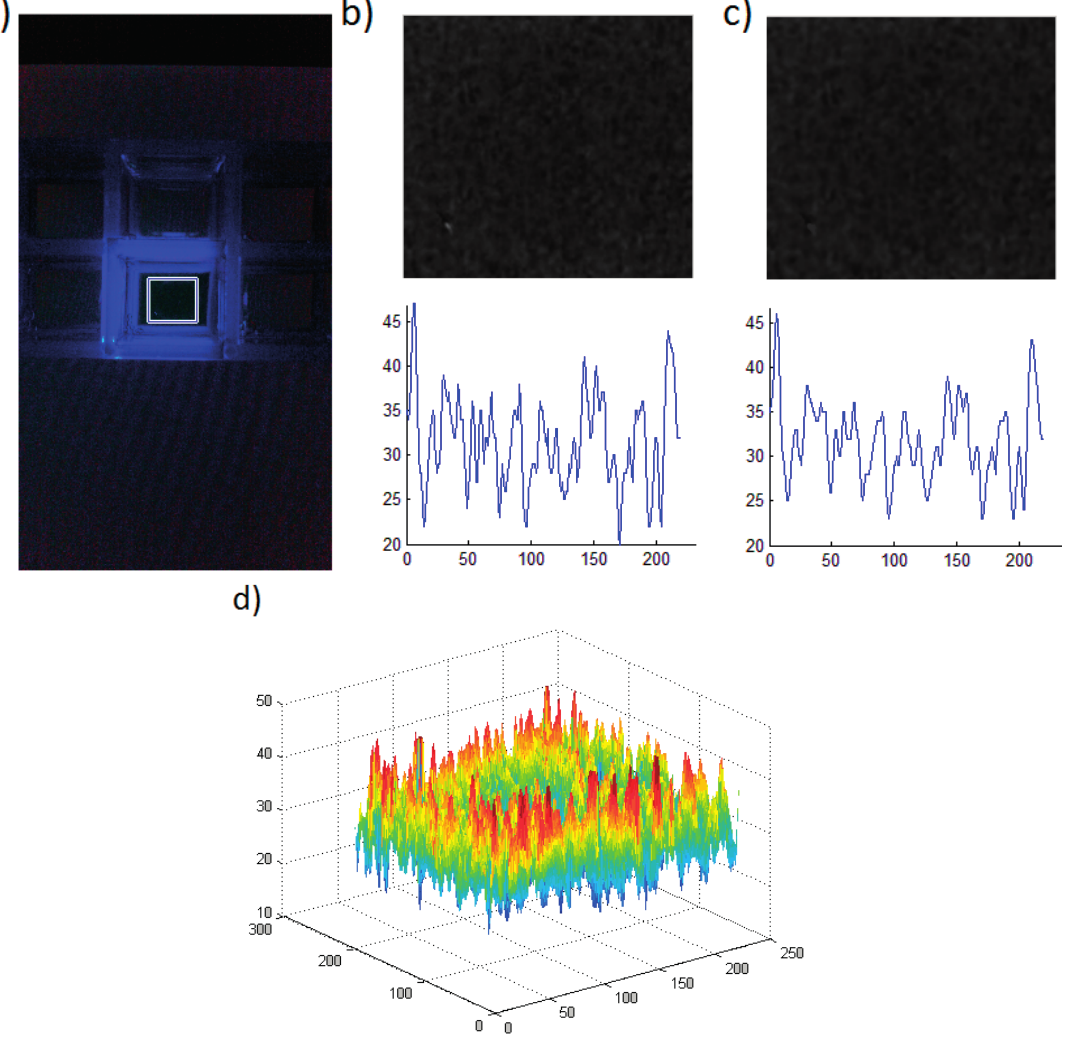
Figure 2. Image processing steps. ( a ) Initial image with the AOA rectangle highlighted; ( b ) Green channel image (in grayscale) and a representative cross-section of screen intensity presenting noise amplitude; ( c ) Image filtered with adaptive Wiener filter and a representative cross-section of intensity presenting noise amplitude; ( d ) Pixel intensity map of the AOA after adaptive